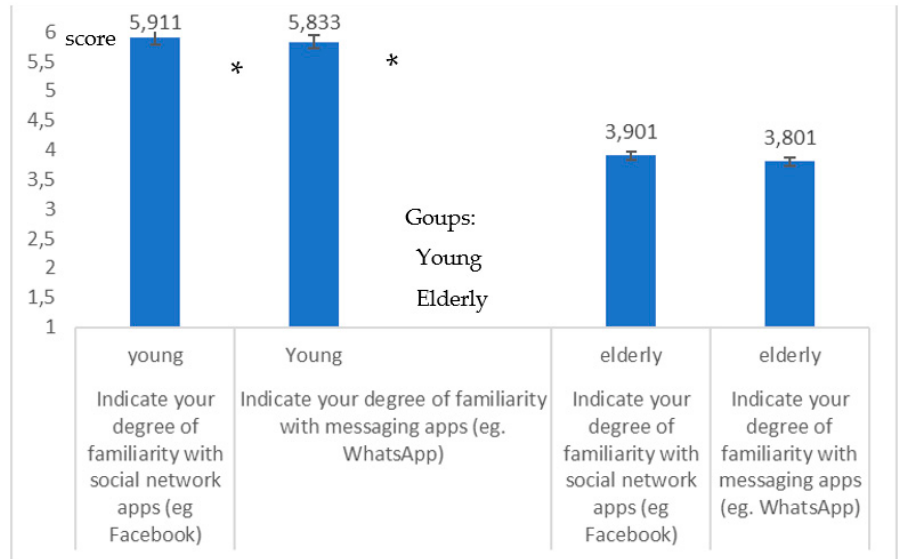
Figure 6. Difference in the degree of familiarity with social networks, Q16 and messaging apps, Q17 for young people and the elderly; the graphic indicates a high difference ( p = 0.008, p = 0.007) between the two groups of young * and elderly.